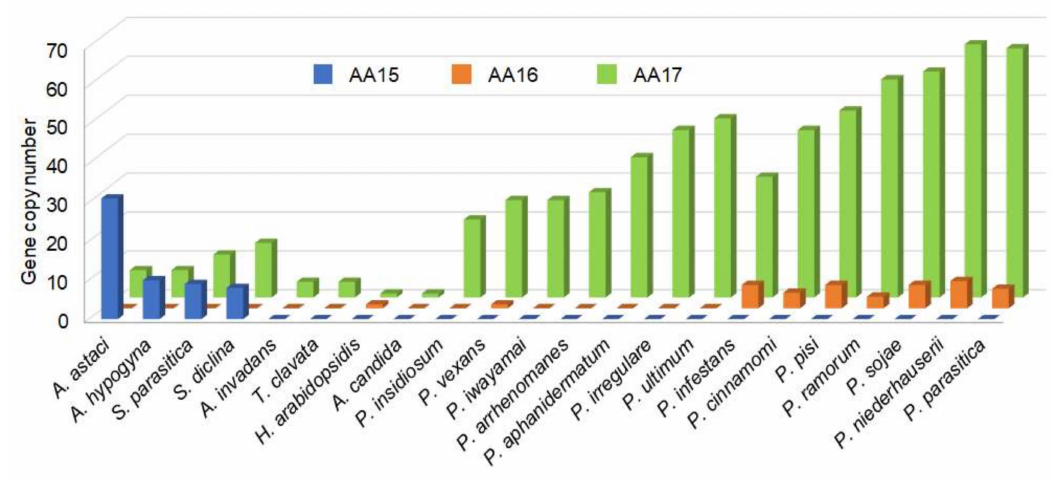
Figure 1. Abundance of LPMO coding genes in oomycete species. AA: Auxiliary Activity. Inspection of predicted oomycete proteomes for the presence of genes encoding hydrolytic chitinases revealed a significant expansion of putative endo-chitinases (GH18, GH19) [30,31] and exo-chitinases (GH20) [32] in A. astaci compared to all other oomycetes (Figure 2a). A similar pattern was observed for the AA15 family in Saprolegniales. These LPMOs are absent in Peronosporales and Pythiaceae (Figure 1), and their gene copy numbers in Saprolegniales appear to be linked to host preference (Figure 2a). Aphanomyces invadans (obligate pathogen of bony fish and the causative agent of Epizootic Ulcerative Syndrome) has no AA15 genes. Only one copy is found in Thraustotheca clavata (free living non- pathogenic saprobe). There are eight copies in Saprolegnia parasitica and Saprolegnia diclina (which can infect fish, fish eggs, amphibians and crustaceans), ten copies in Achlya hypogyna (facultative crustacean decapod parasite) and thirty-one copies in A. astaci (preferential parasite of crustacean decapods). AA15 gene copy number is, therefore, much higher in necrotrophic species that infect aquatic animals, particularly crustaceans. This trend suggests a specialized role for these LPMOs in attacking a protective structural component abundant in crustaceans yet absent or scarce in plants and bony fish, which we speculated could be chitin. Supporting this hypothesis, in the genome of A. astaci , we identified a genomic island composed of nine identical AA15 genes (spanning from H257_10979 to H257_10987), similar to bacterial high-density pathogenicity islands (PAIs) typically involved in infection [33]. Phylogenetic analysis also shows that A. astaci AA15 sequences cluster separately from those found in other Saprolegniales (Figure